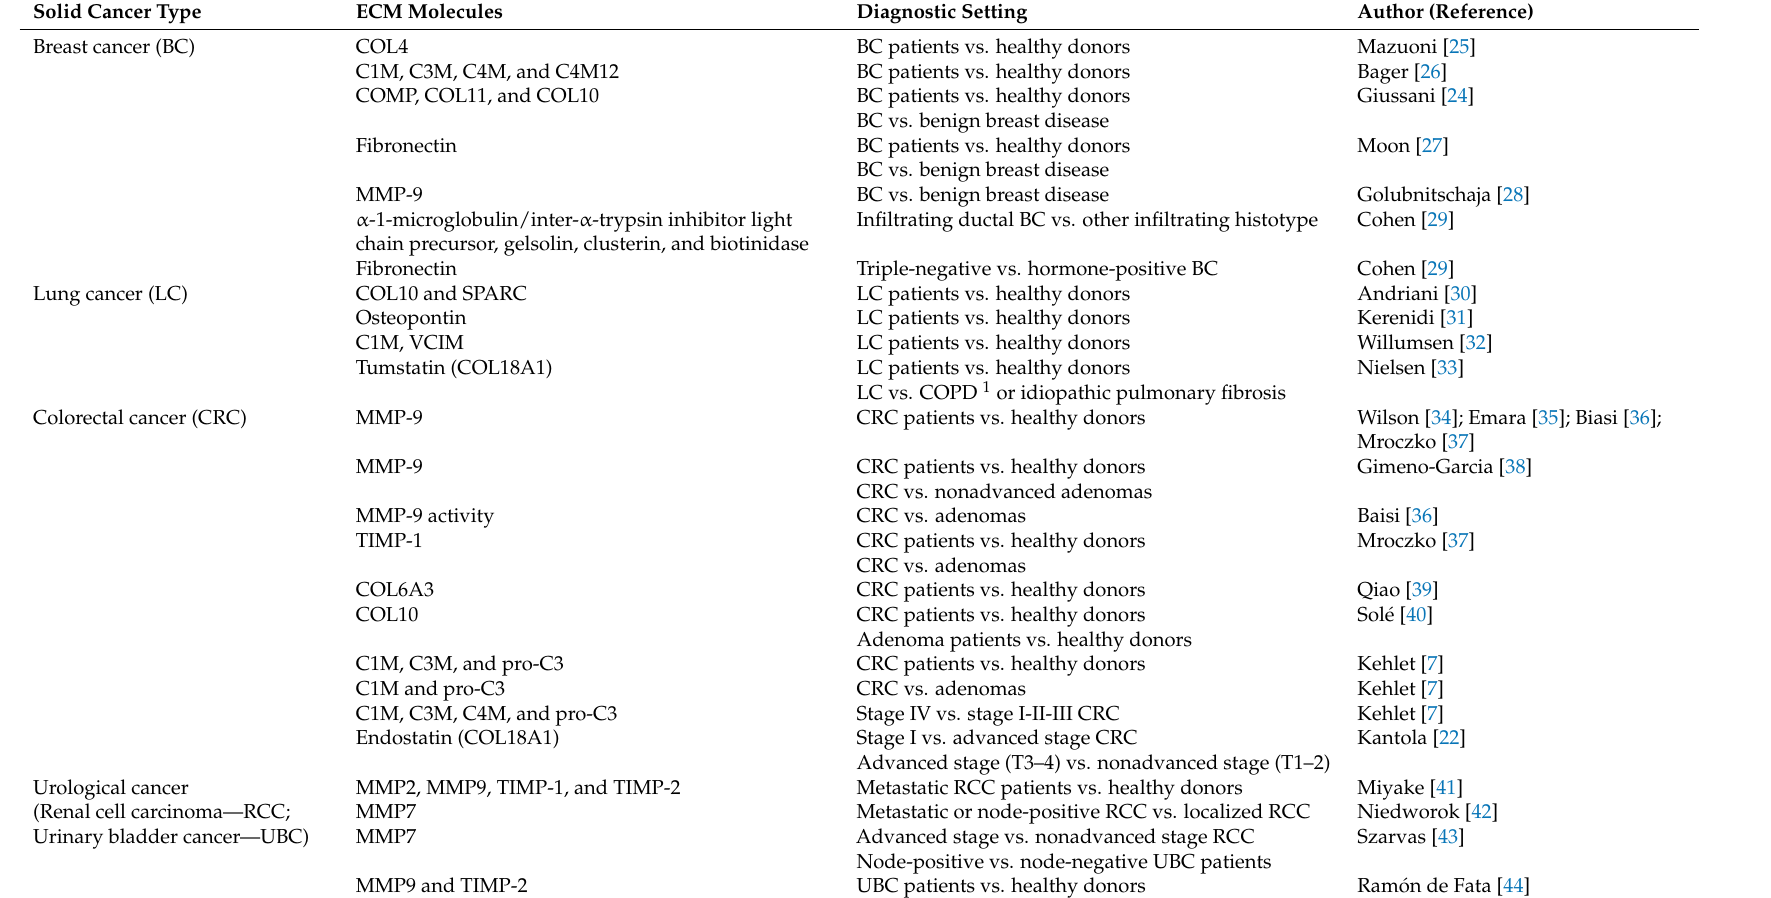
Table 1. Extracellular matrix (ECM)-derived molecules in cancer